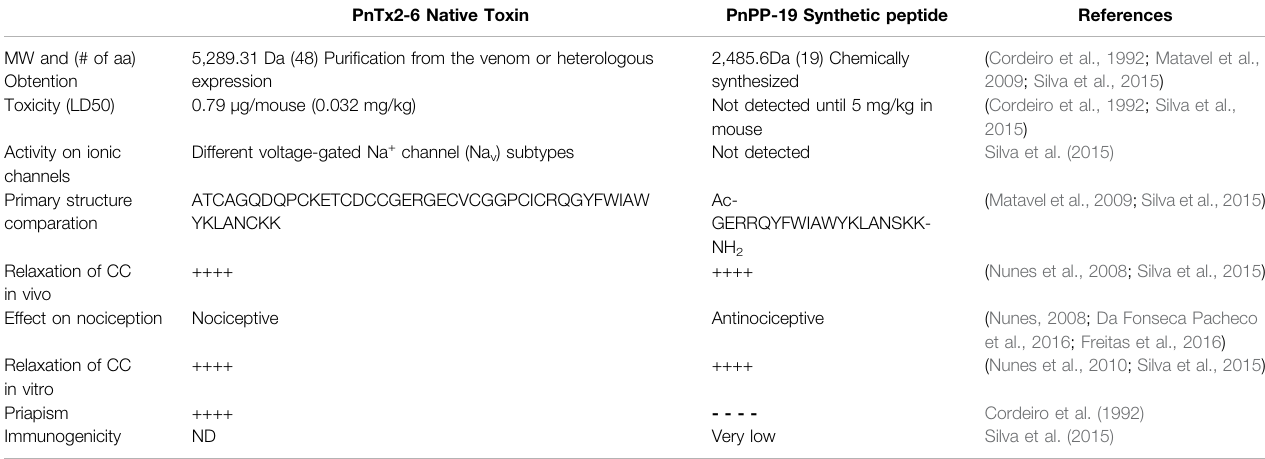
TABLE 1 | Pharmacological, biochemical, and physiological data comparing the toxin PnTx2-6 and the synthetic peptide PnPP-19.